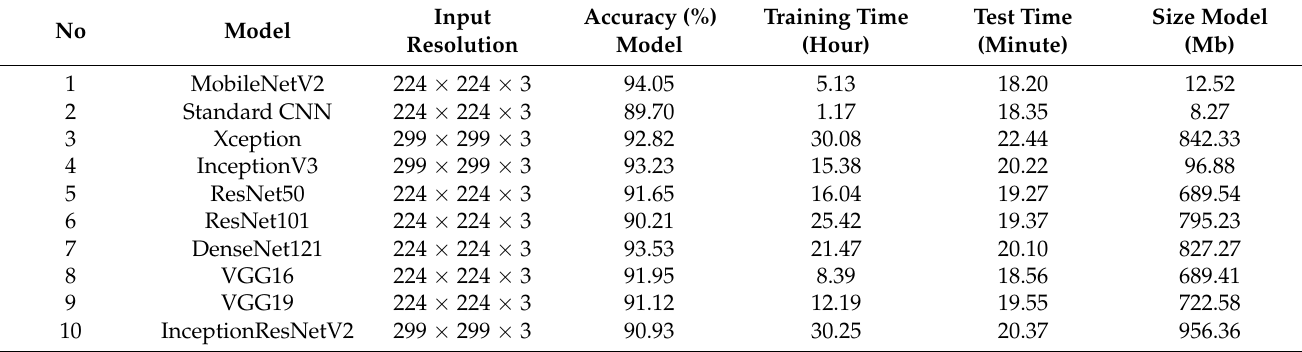
Table 6. Evaluation of the runtime performances of CNN networks on our dataset at epochs =